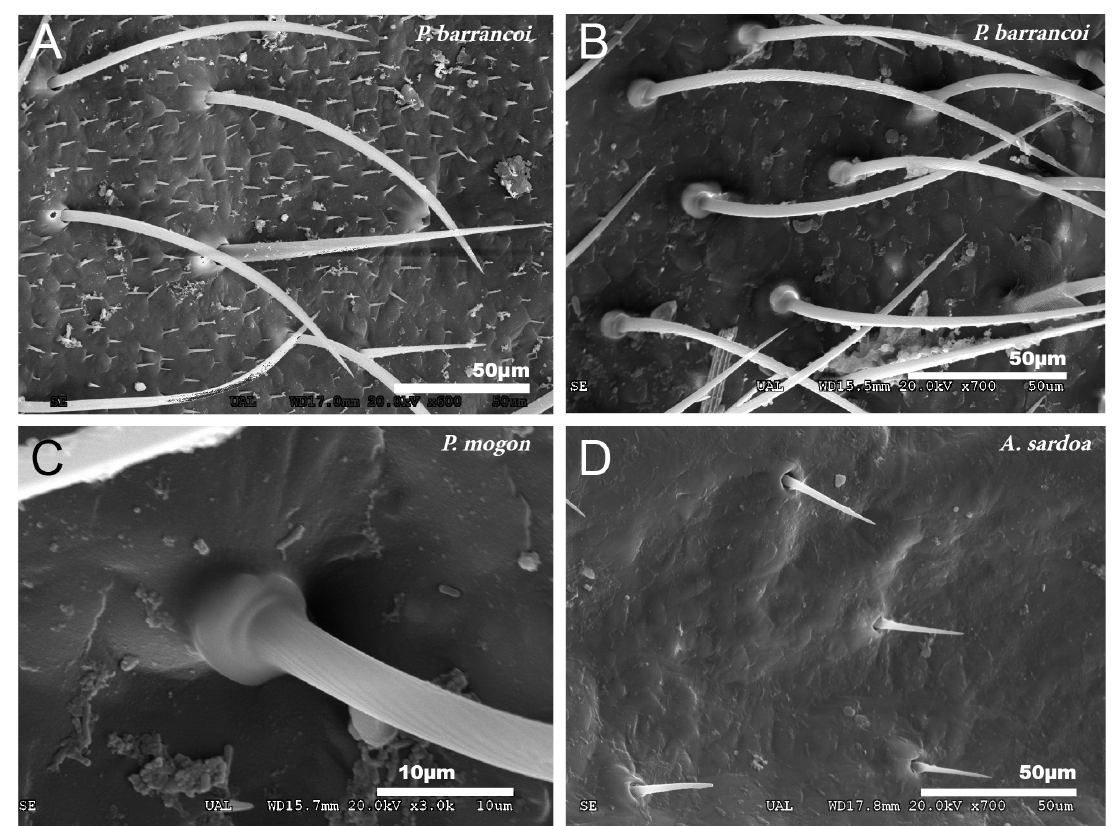
Figure 3. Types of insertion observed in tegmina setae. ( A ) P. barrancoi , inserted in a small tumulus; ( B , C ) P. mogon , inserted in a more developed capsule-shaped tumulus and ( D ) A. sardoa , inserted directly on the pore.